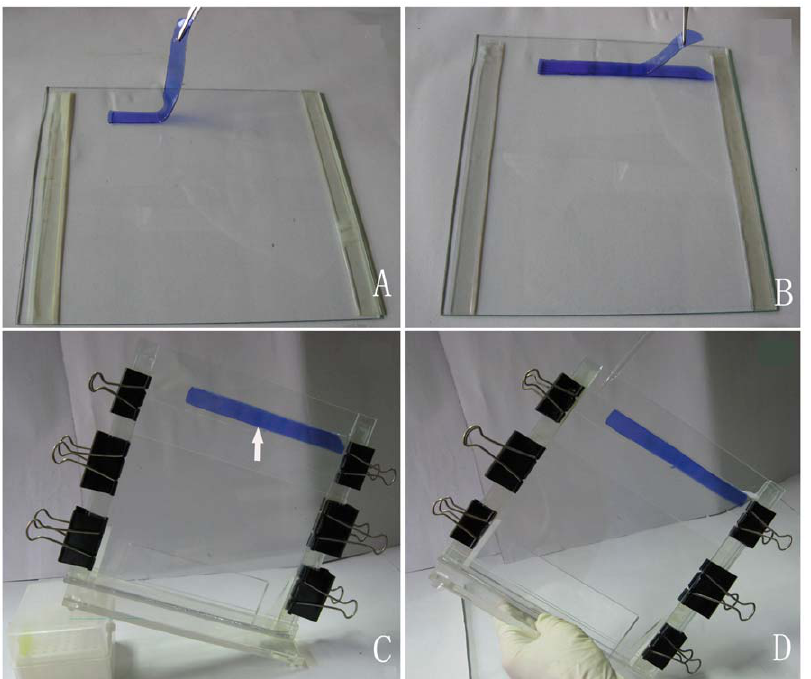
Figure 2. The operation of a novel ‘‘Double-Strips 2D BN/SDS-PAGE’’ transfer technique from the first dimension to the second. A : One strip of 1D BN-gel lane was placed in the glass plate after denaturing. B : The other identical BN-gel strip was covered to the previous according to the aligned protein complexes, and then the glass plate was overlapped on the gels. C : The cassette was placed in skew form avoiding air bubble produced, the agarose was poured in the space between the BN-gel and stacking gel (just the half of all volume, as arrow indicated) after acrylamide was polymerized. D : The remaining space was subsequently filled with agarose until the previous solution has been concreted.